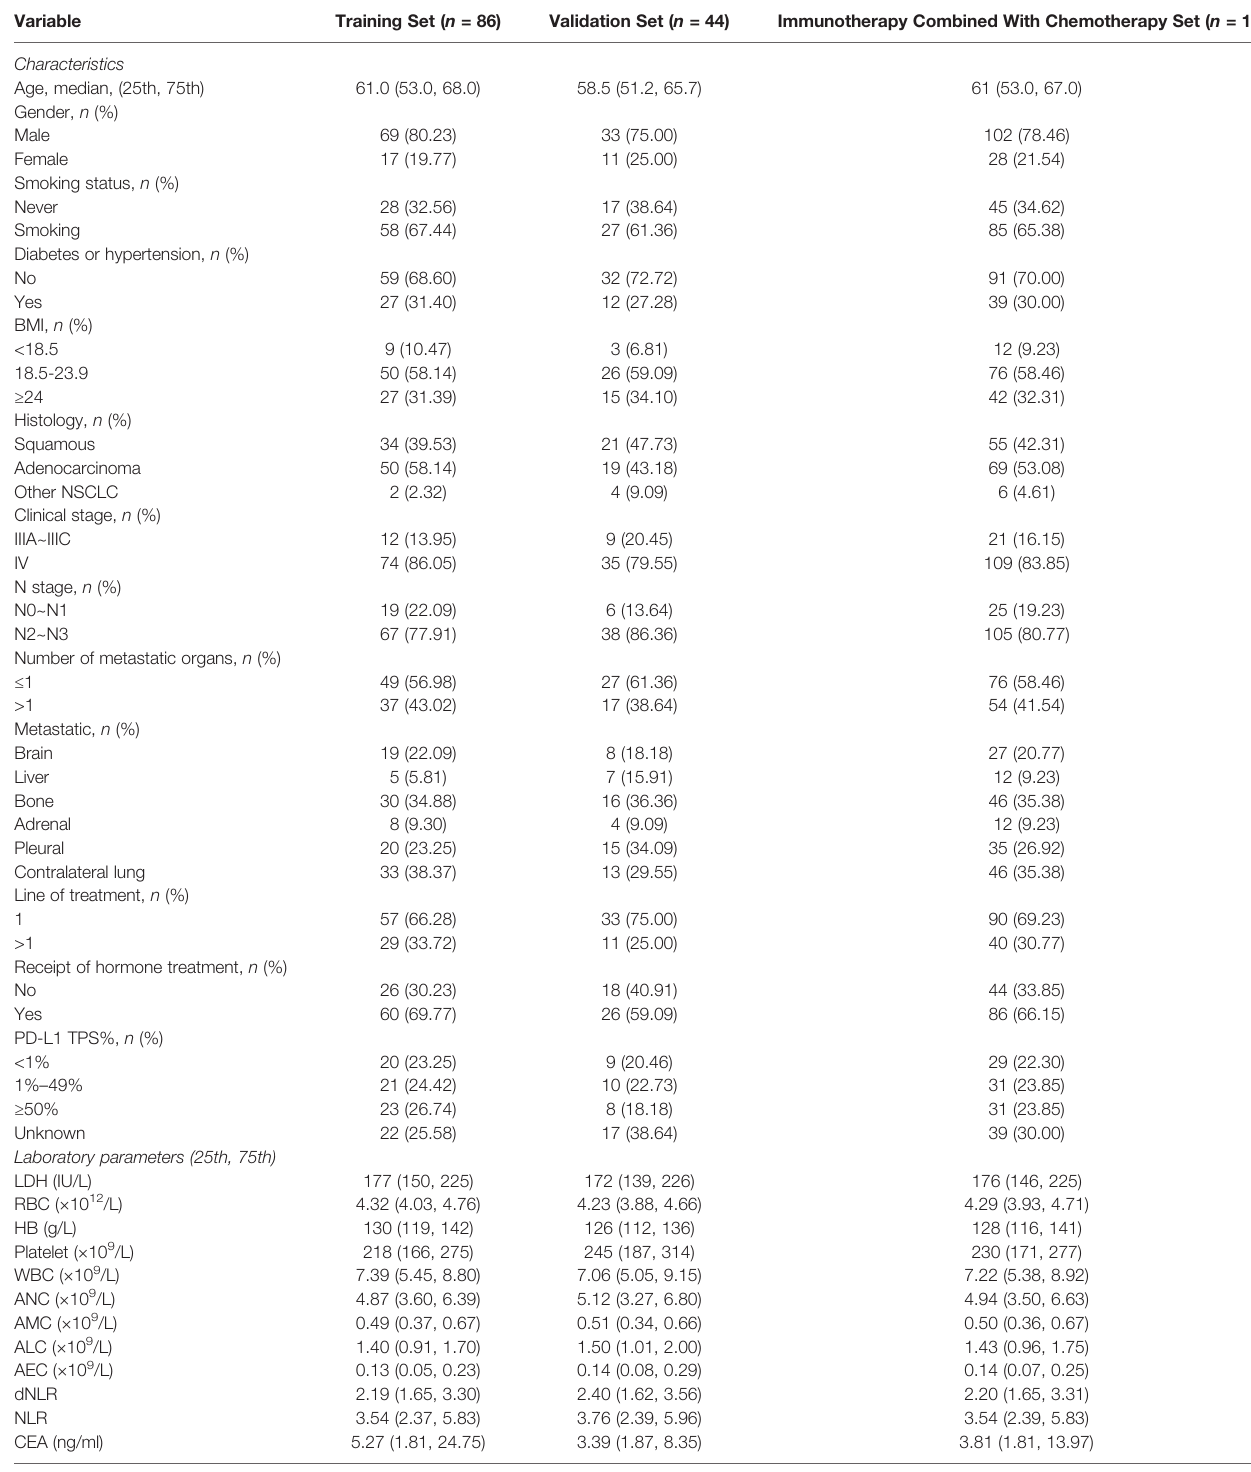
TABLE 1 | Baseline clinical characteristics and laboratory